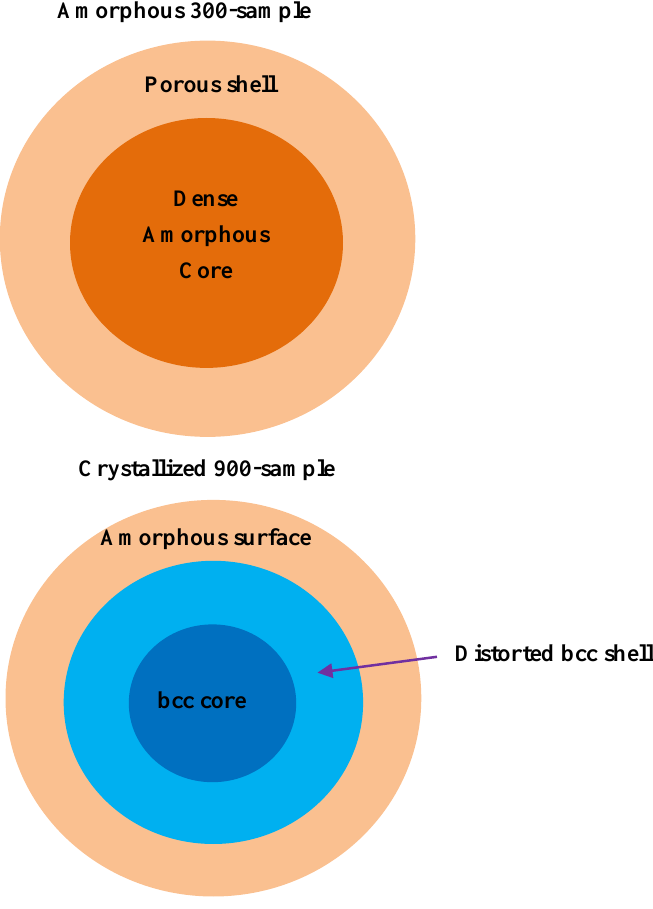
Figure 9. Schematics of separate regions with different